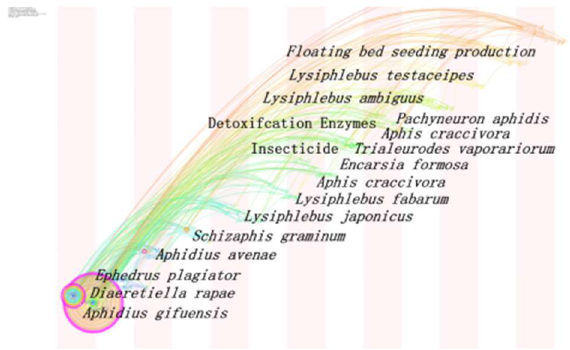
Figure 3. The timeline of aphids parasitoids research in